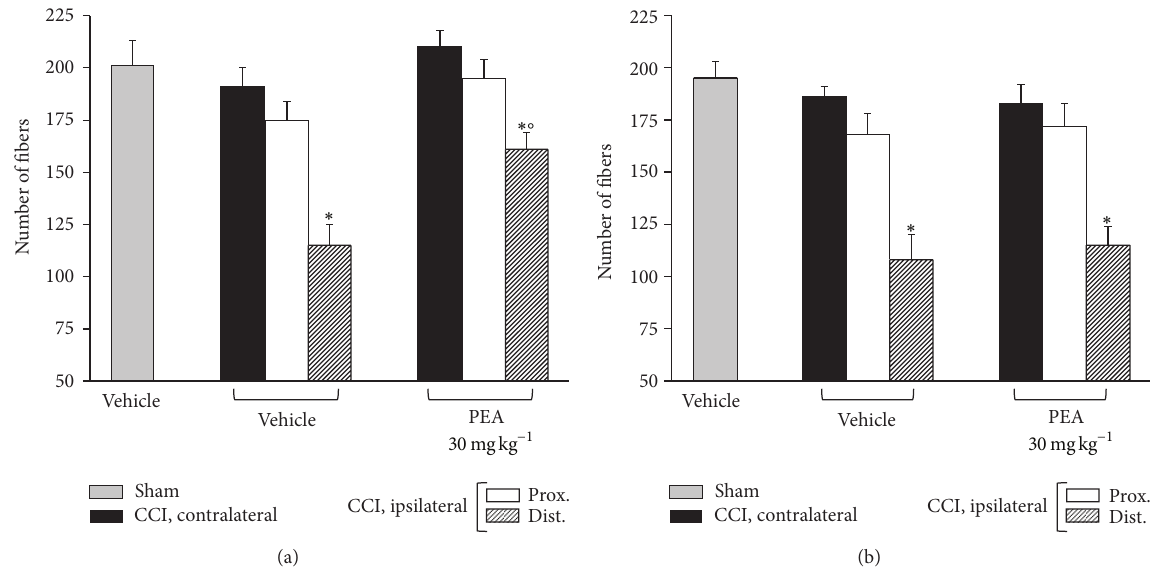
Figure 2: Morphometry: number of fibers. 5 𝜇 m nerve sections of osmium-fixed tissues were analyzed. The distal and the proximal tract of the ipsilateral ligated nerve (CCI) was compared with the contralateral and with the sciatic nerve of sham-operated animals (sham). Effect of repeated PEA administrations (30mgkg −1 s.c. for 14 days) on the number of nervous fibers in respect to vehicle-treated CCI animals and vehicle-treated sham animals. (a) PPAR- 𝛼 +/+ mice versus (b) knock-out animals. Quantitative analysis was performed evaluating 5 animals for each group. ∗ 𝑃 < 0.05 was considered as significantly different from sham, vehicle-treated mice. ∘ 𝑃 < 0.05 was considered as significantly different from CCI, vehicle-treated